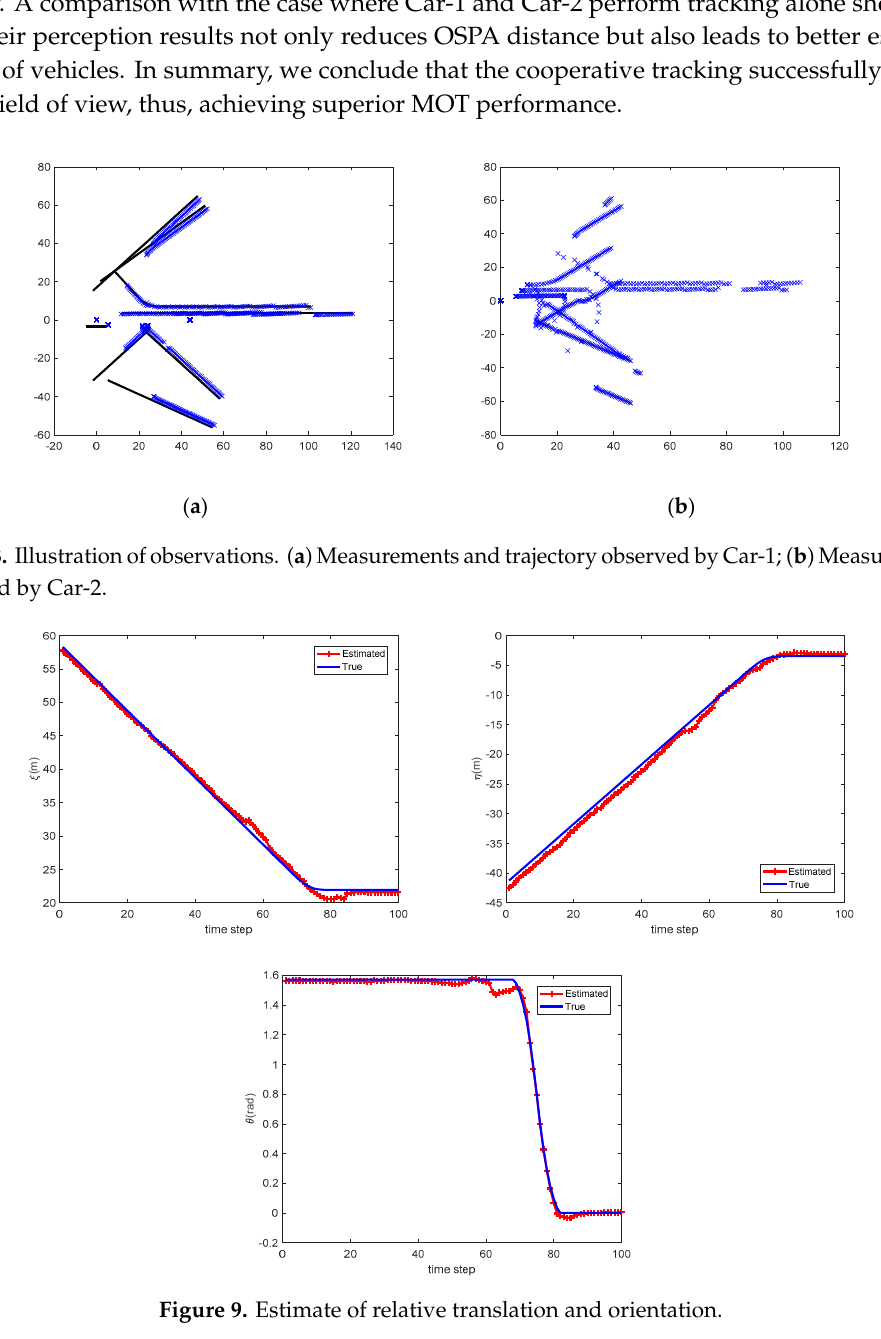
Figure 9. Estimate of relative translation and orientation.